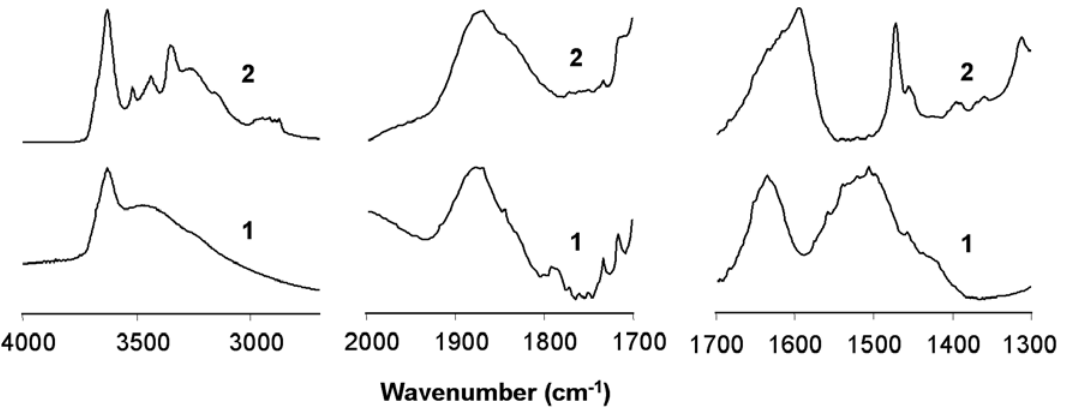
Fig. 3 FT–IR spectra of the air-dried montmorillonite (1) and the montmorillonite- immobilised Cu-tren complex (2, Mont–i–Cu-tren).